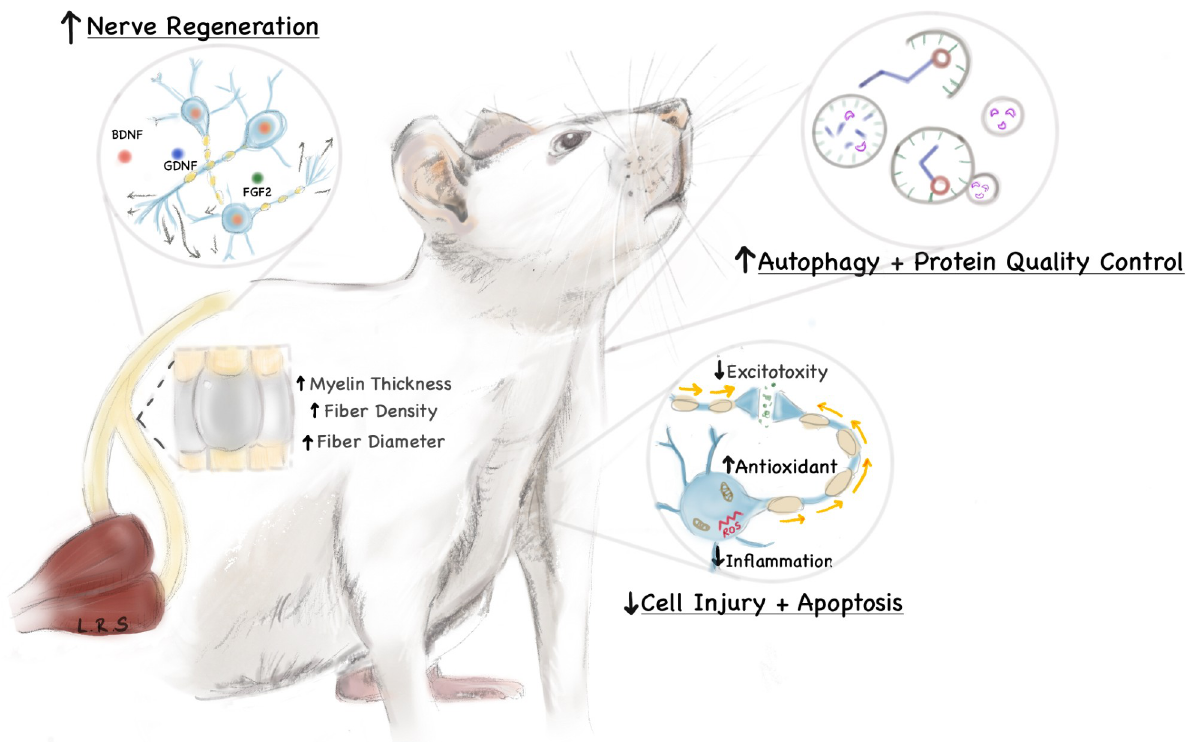
Fig 2. Potential mechanisms promoting nerve regeneration and repair in a ketogenic milieu. The ketogenic diet may promote regeneration and repair following neuronal injury through a variety of mechanisms, including upregulation of neurotrophic factors, enhanced autophagy, diminished excitotoxicity, and reduced inflammation. The mediators of these effects are thought to be ketone bodies, which are hepatically-derived byproducts of fatty acid oxidation formed during fasting or low-carbohydrate states.